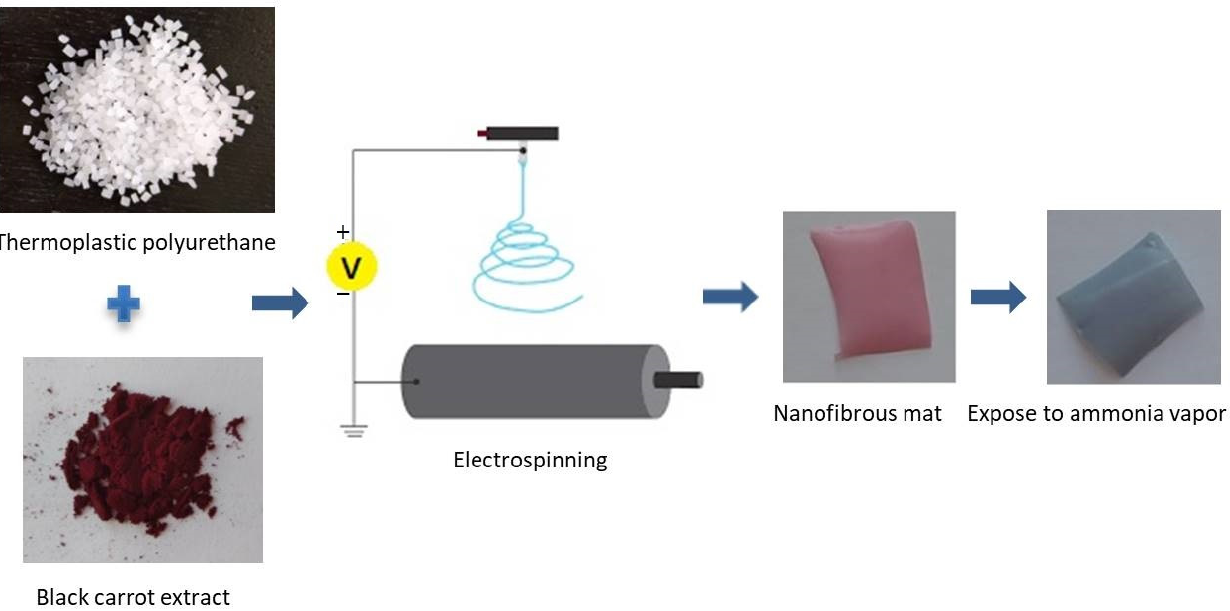
Figure 1. The facile method and experimental study of developing a colourimetric polyurethane nanofibrous sensor containing natural indicator dye for detecting ammonia vapour.